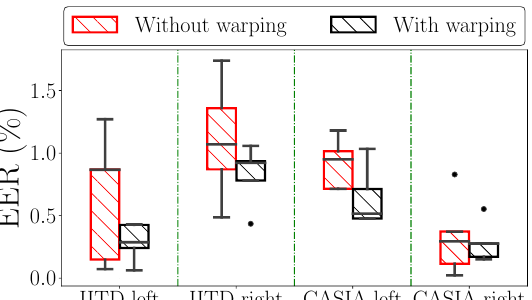
right0 . IITD left IITD right CASIA left CASIA Figure 13. Equal error rate (EER) box plot visualization showing the effect before and after includ- ing the TPS warping as image transformation in the existing augmentations when the Two-path architecture is trained on either left or right palmprints from IITD and CASIA